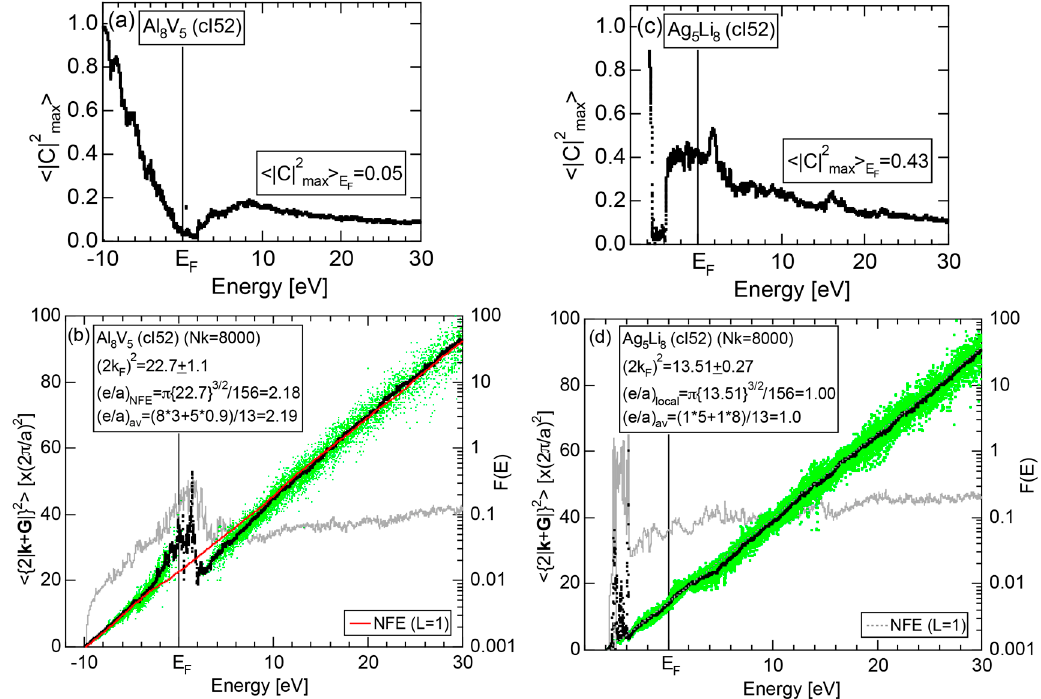
(cid:68) (cid:69) Figure 35. ( a ) C max2 and ( b ) Hume-Rothery plot for Al 8 V 5 (cI52). Respective data in ( c , d ) for Ag 5 Li 8 (cP52). See captions of Figure 34b,d for symbols. The NFE curve in ( b ) is drawn with red color, since the NFE method is used.